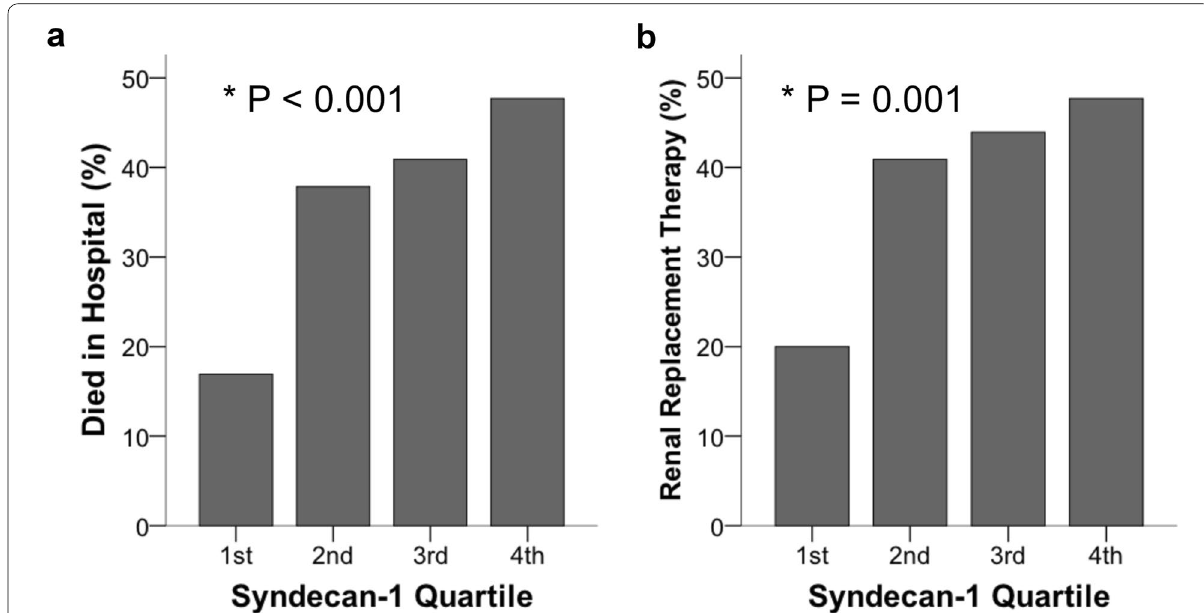
Fig. 4 Clinical outcomes including a hospital mortality and b need for renal replacement therapy were strongly associated with increasing plasma syndecan-1 levels in 262 patients with sepsis. p values by linear-by-linear association test